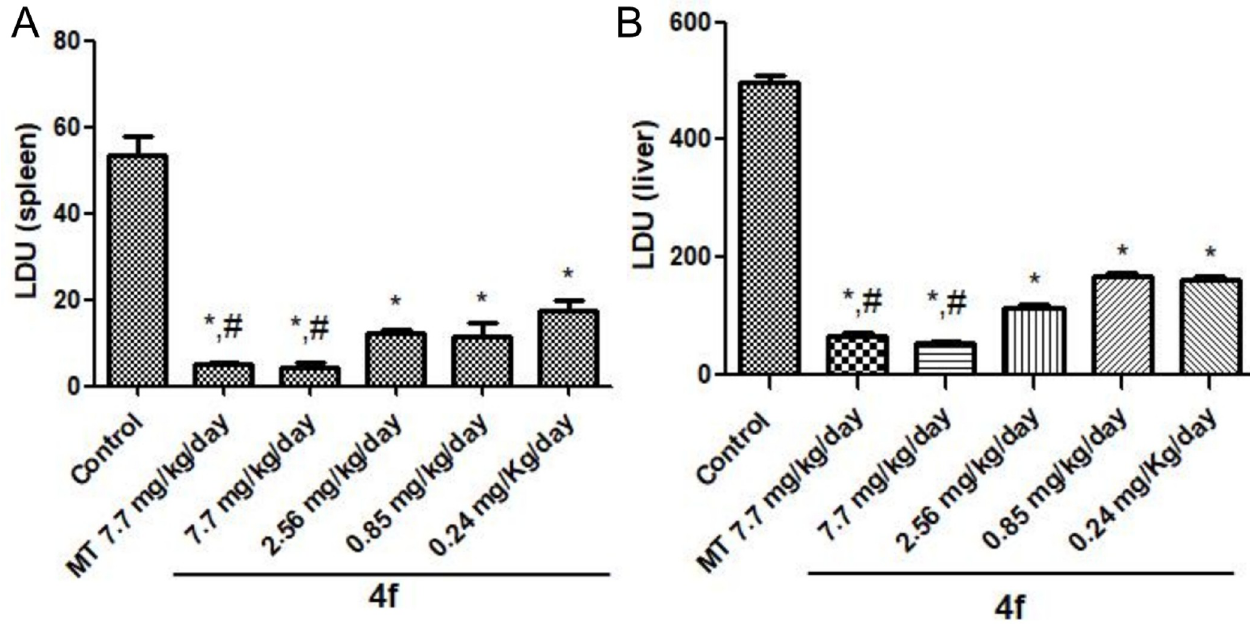
Fig 4. Parasite load evaluation. The LDU index (number of Leishmania amastigotes in 1,000 nucleated cells per organ weight) was determined in the spleen ( A ) and liver ( B ) of L . infantum infected BALB/c mice using. The data are expressed as average ± SD. Control: Infected and non-treated animals. MT: miltefosine. � : Statistically significant difference in all groups compared to the Infected and non-treated animals (p < 0.0001). #: Not statistically significant (p > 0.05).